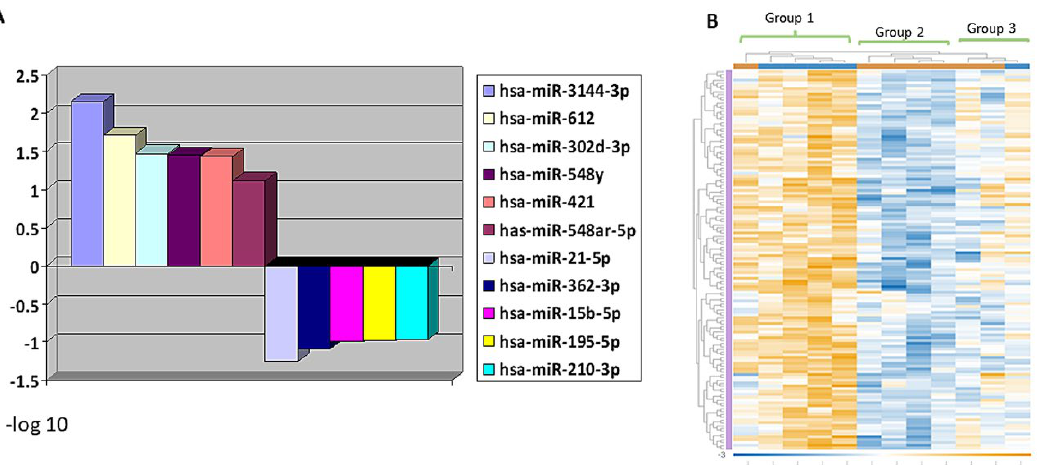
Figure 3. Differential expression of miRNA. ( A ) The topmost significantly altered miRNA expression according to p value (Y axis = − log 10). ( B ) Heat map revealing differential expression and clustering of miRNAs expression in each RMS group.